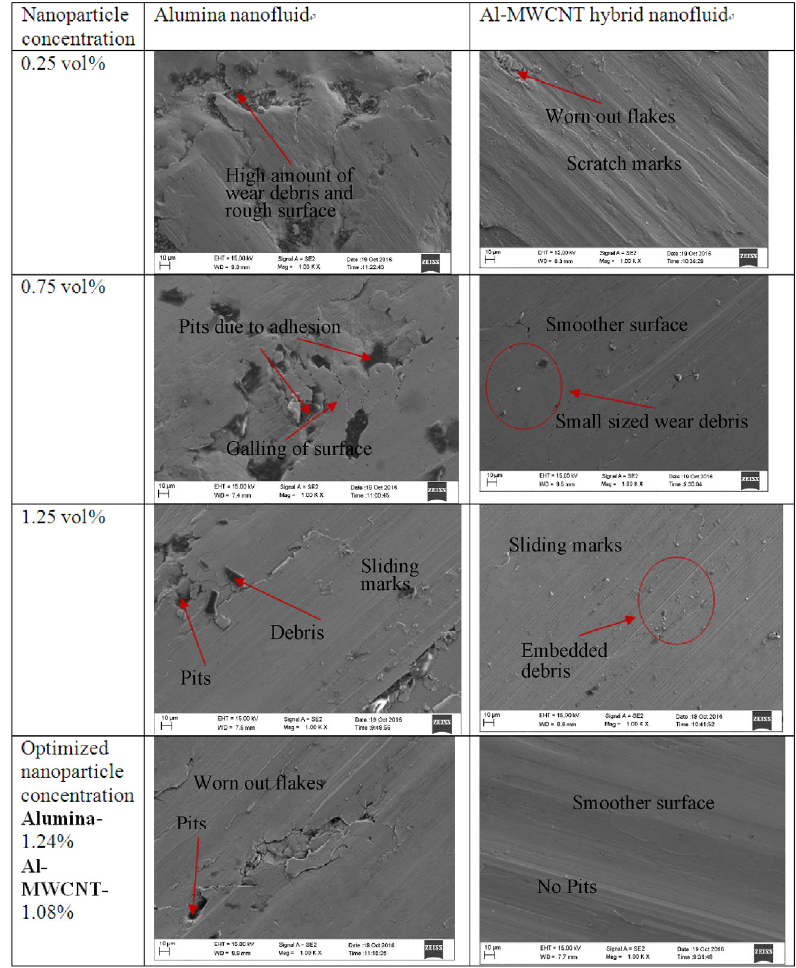
Fig. 10 FESEM images of sliding surface of pins achieved during pin-on-disc tribology